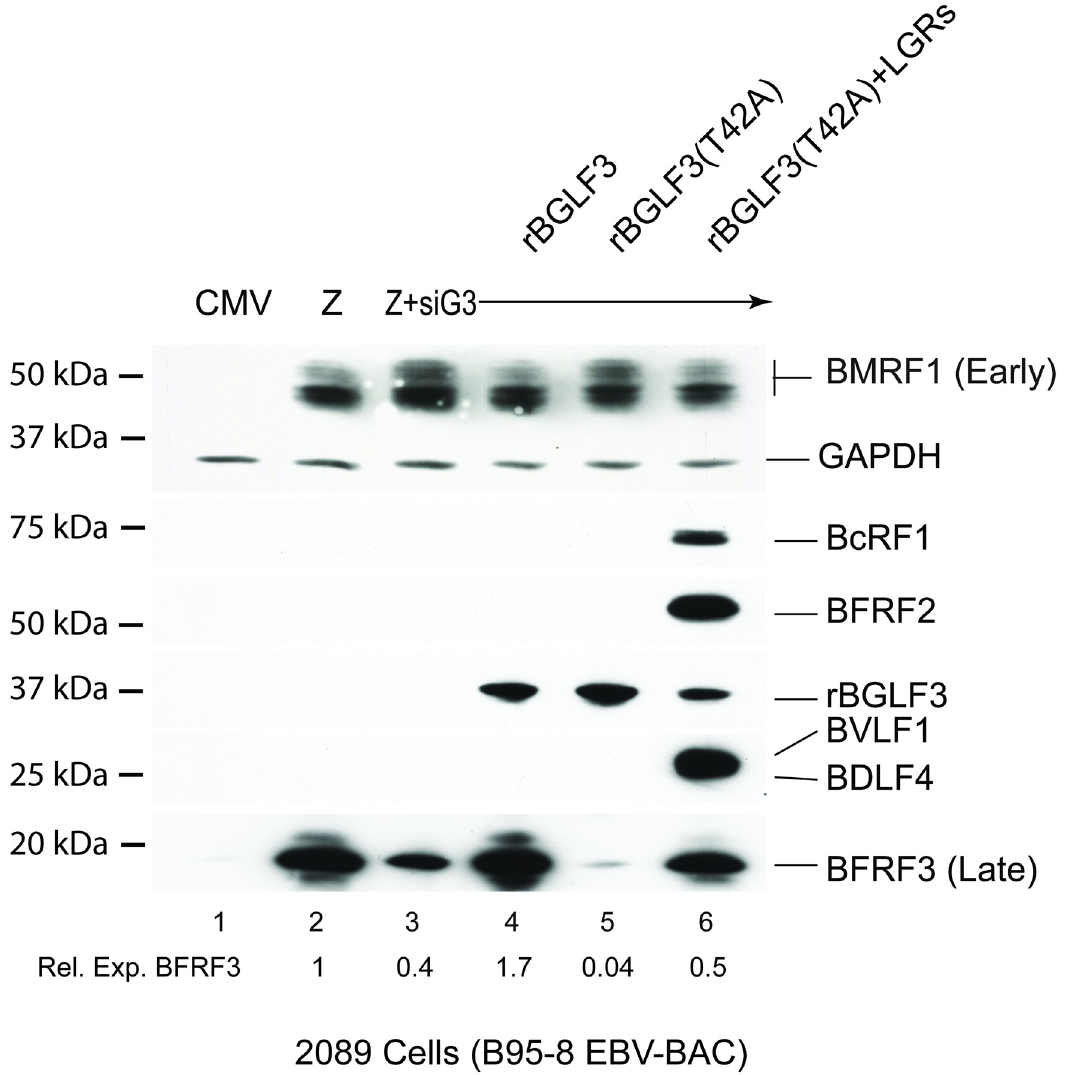
Fig 5. vPIC partially overcomes the defect in the capacity of BGLF3(T42A) to activate late gene expression. Western blot analysis of 2089 cell lysates demonstrating the capacity of vPIC to suppress the phenotype of BGLF3(T42A) and partially restore expression of late genes. Cells were transfected with empty vector (CMV), ZEBRA (Z), and ZEBRA plus siBGLF3. Knockdown of endogenous BGLF3 was complemented with siBGLF3-resistant wild type BGLF3 (rBGLF3) or mutant protein [rBGLF3(T42A)] in the absence and presence of four late gene regulators (LGRs): BcRF1, BDLF4, BFRF2, and BVLF1. Cell lysates were prepared 48h after transfection and were analyzed by immunoblotting. All late gene regulators were detected with anti-FLAG antibody. GAPDH served as a loading control. The membrane was re-blotted with antibody specific to early BMRF1 and late BFRF3 proteins. The experiment is a representative of three biological